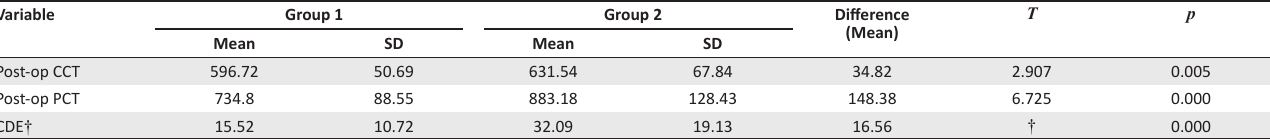
TABLE 5: Comparison between Group 1 and Group 2 surgeons according to post-operative central corneal thickness, and post-operative peripheral corneal thickness and cumulative dissipated energy. Variable